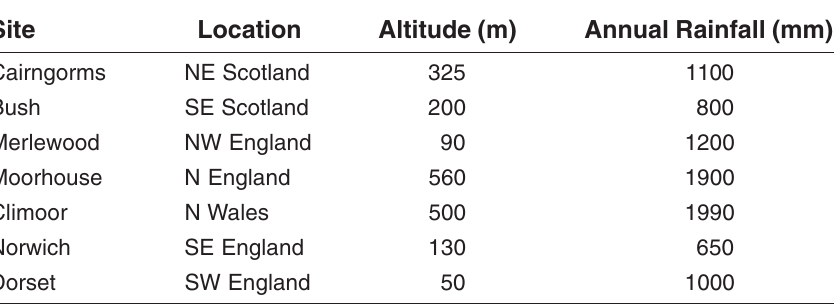
Long-Term (>1 Year) U.K. Network Measurement